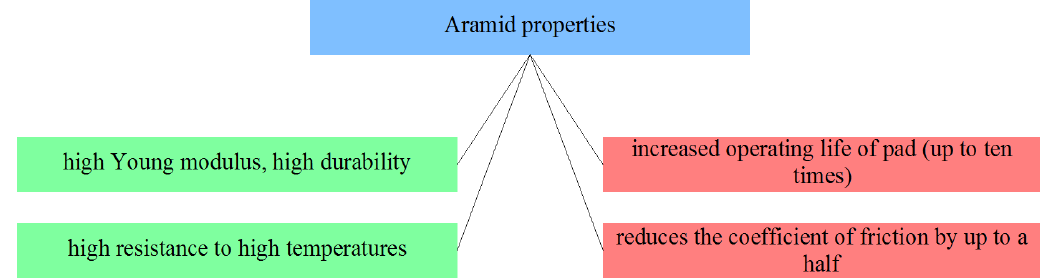
Figure 11: Selected aramid properties from the point of view of applicability in friction